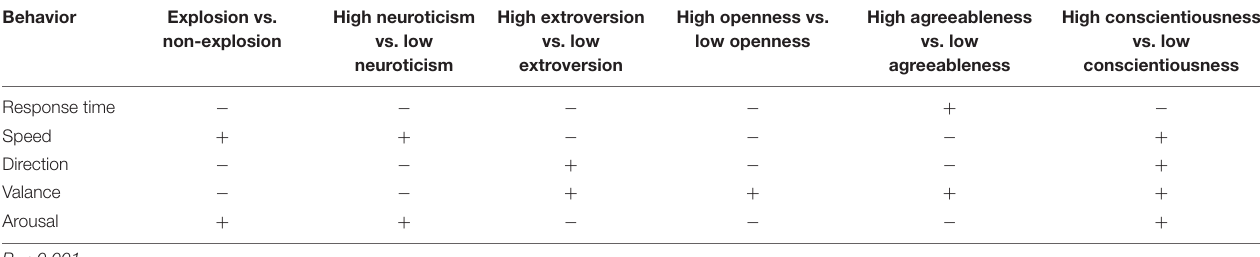
TABLE 13 | The main effects of explosion experiment and personality dimensions on individual emotional impact and escape behavior. Behavior